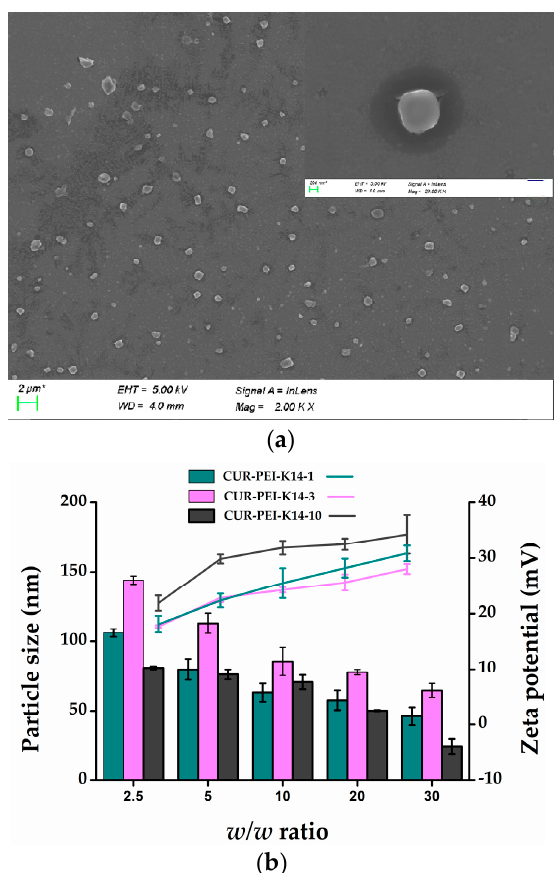
Figure 3. Agarose gel electrophoresis of plasmid DNA and ( a ) CUR-PEI-K14-1, ( b ) CUR-PEI-K14-3, and ( c ) CUR-PEI-K14-10 complexes at various w / w ratios.